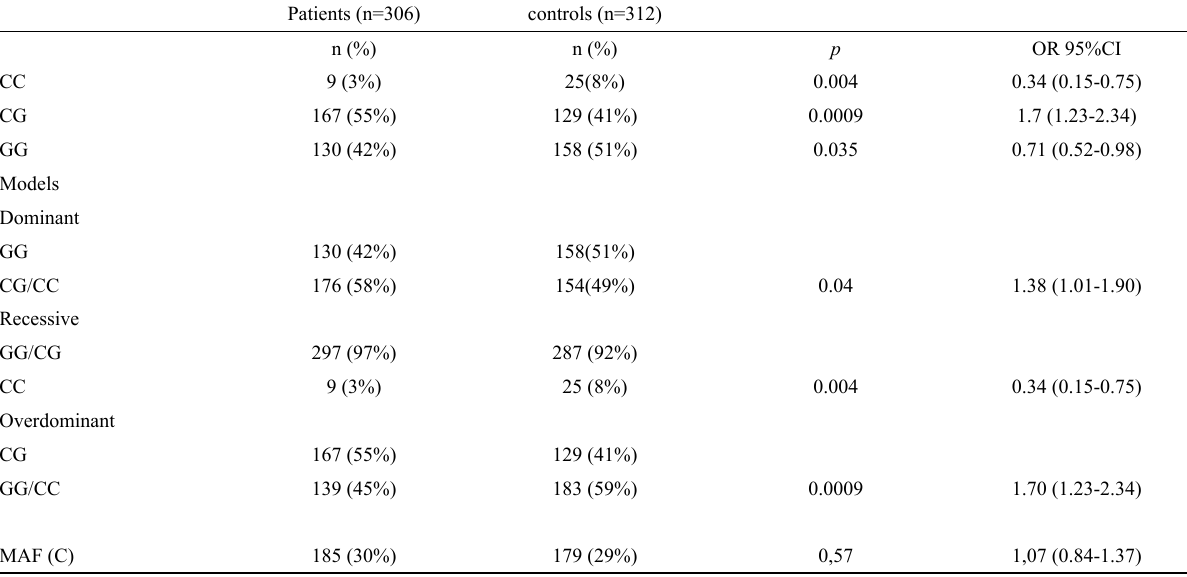
Table 2 – Genotype and allele frequencies of rs527616 in patients and